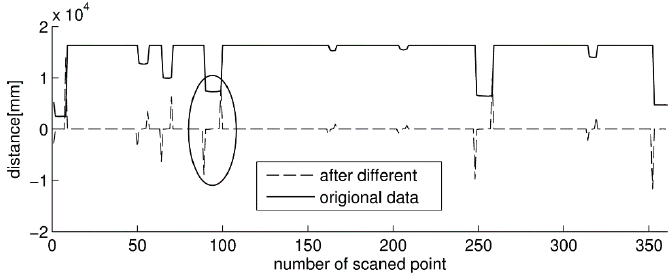
Figure 5. The schematic of the difference calculation for clustering the raw laser